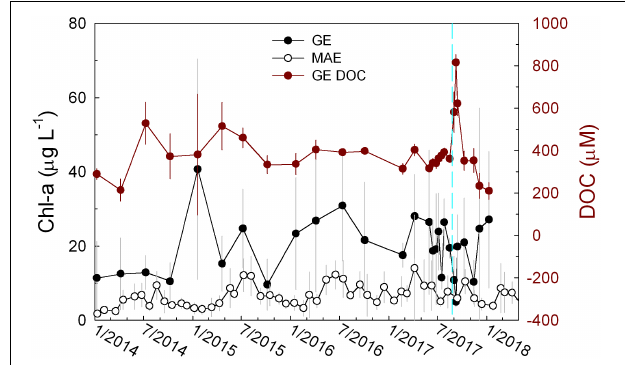
FIGURE 6 | Temporal distributions of chlorophyll a concentration in both GE and MAE. DOC from GE is shown in brown